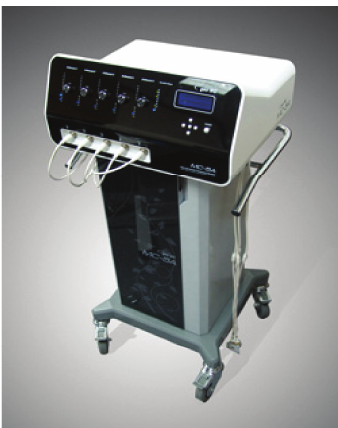
Figure 1: Calmare MC-5A (http://www.lifeepistemeitalia.it/calmare- mc-5a/dati-tecnici/).